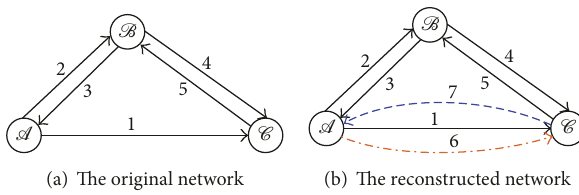
Figure 2: An illustrative example to reconstruct the